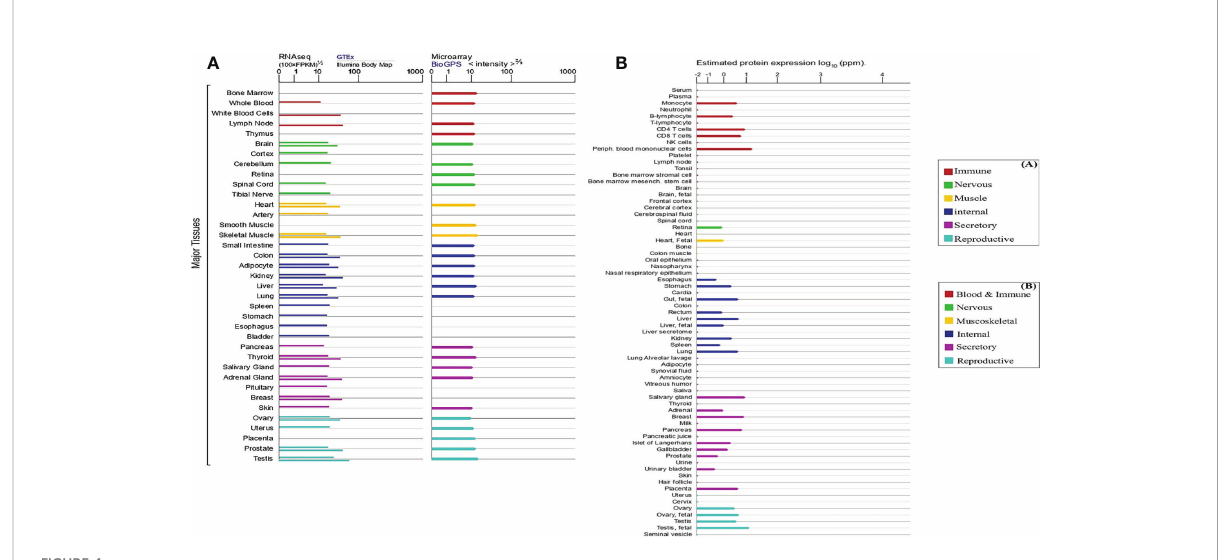
FIGURE 4 Expression level of human ribonuclease P protein subunit p30 ( RPP30 ) RNA and protein in different tissues and cells (line colors indicate tissue types and length indicates levels of expression). (A) Expression of RPP30 RNA using RNA sequencing (left: expression results above gray horizontal lines are from the Genotype-Tissue Expression (GTEx) database and those below are from the Illumina Body Map) and microarray (right: from the BioGPS database); (B) Protein expression in normal tissues and cell lines from Proteomics DB, the MaxQuantDataBase (MaxQB), and Multi-Omics Pro fi ling Expression Database